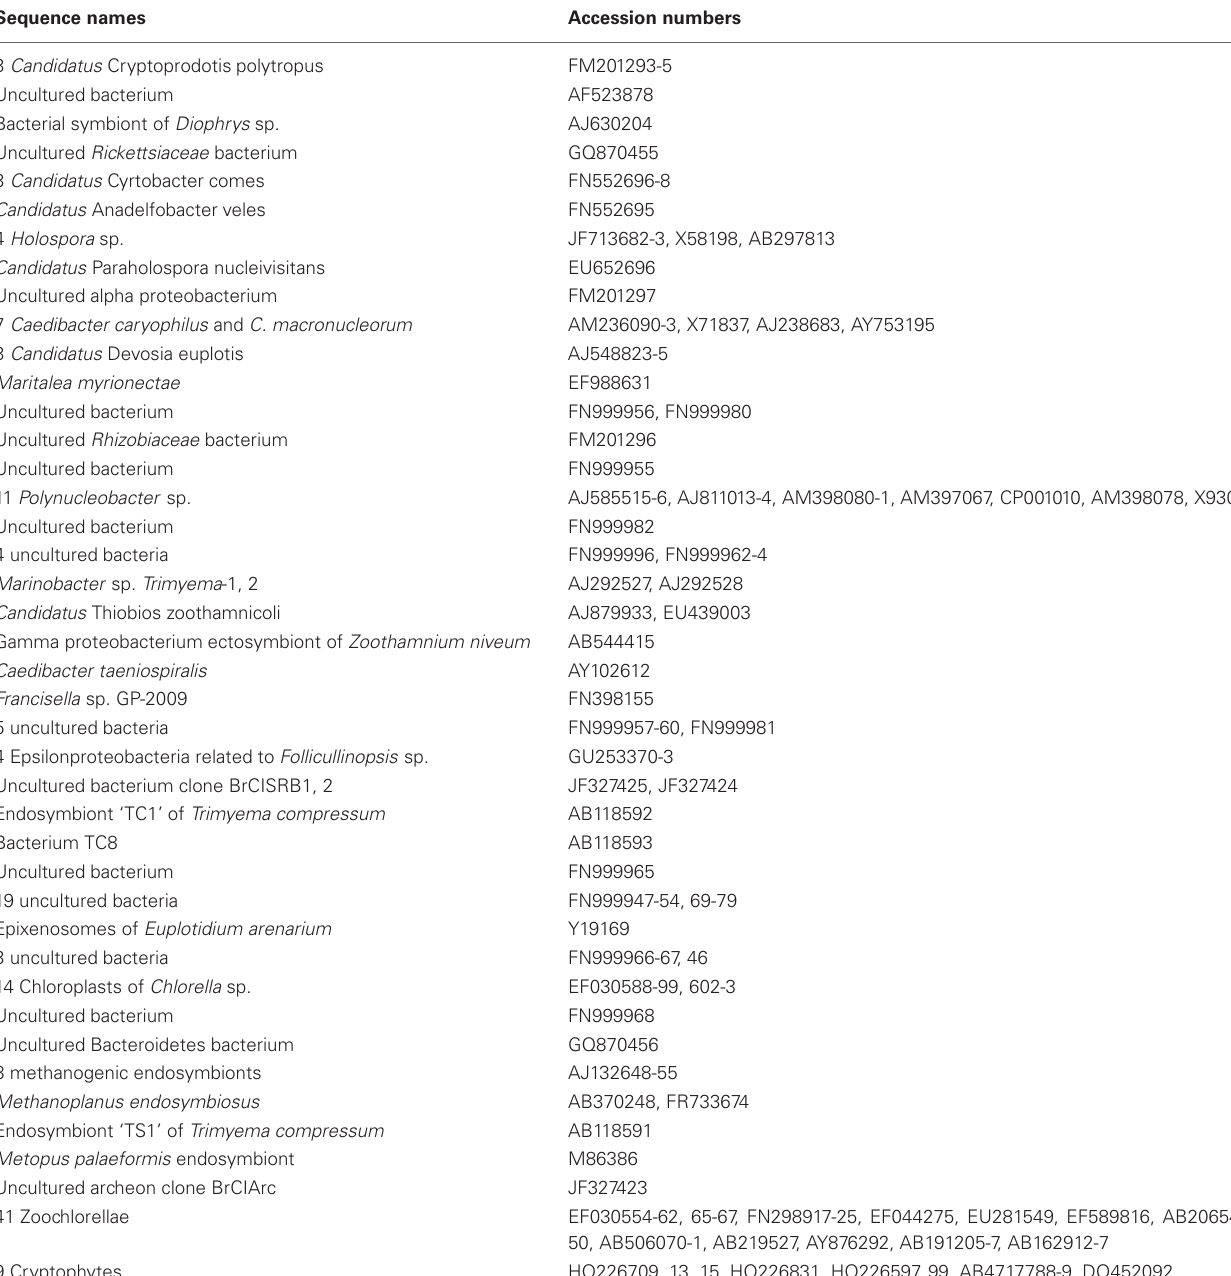
Table A1 | Used published sequences (order according to the phylogenetic tree in Figure